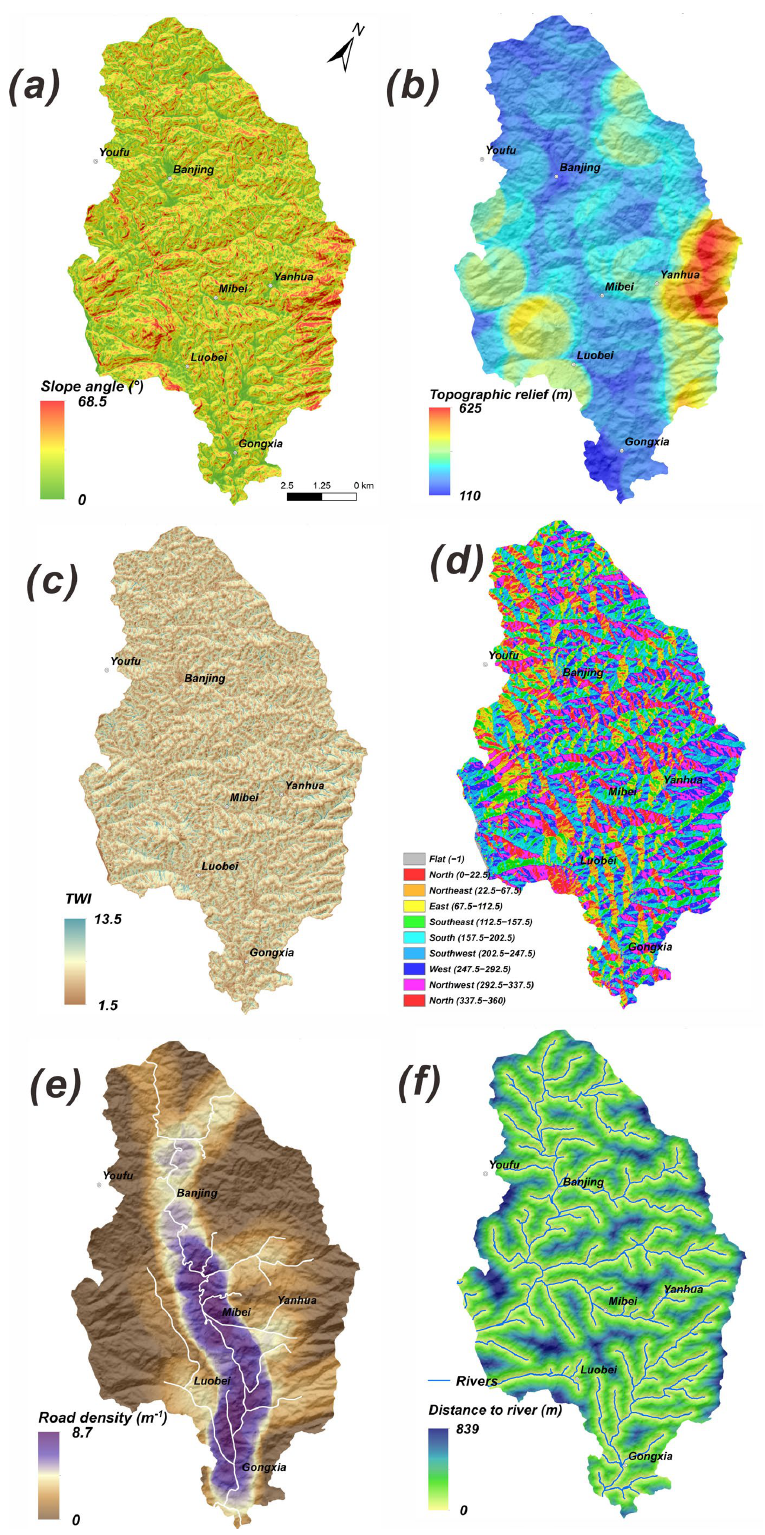
Figure 9. Mapping showing the distribution of the influencing factors in the study area; ( a ) slope angle; ( b ) topographic relief; ( c ) topographic wetness index; ( d ) aspect; ( e ) road density; ( f ) distance to